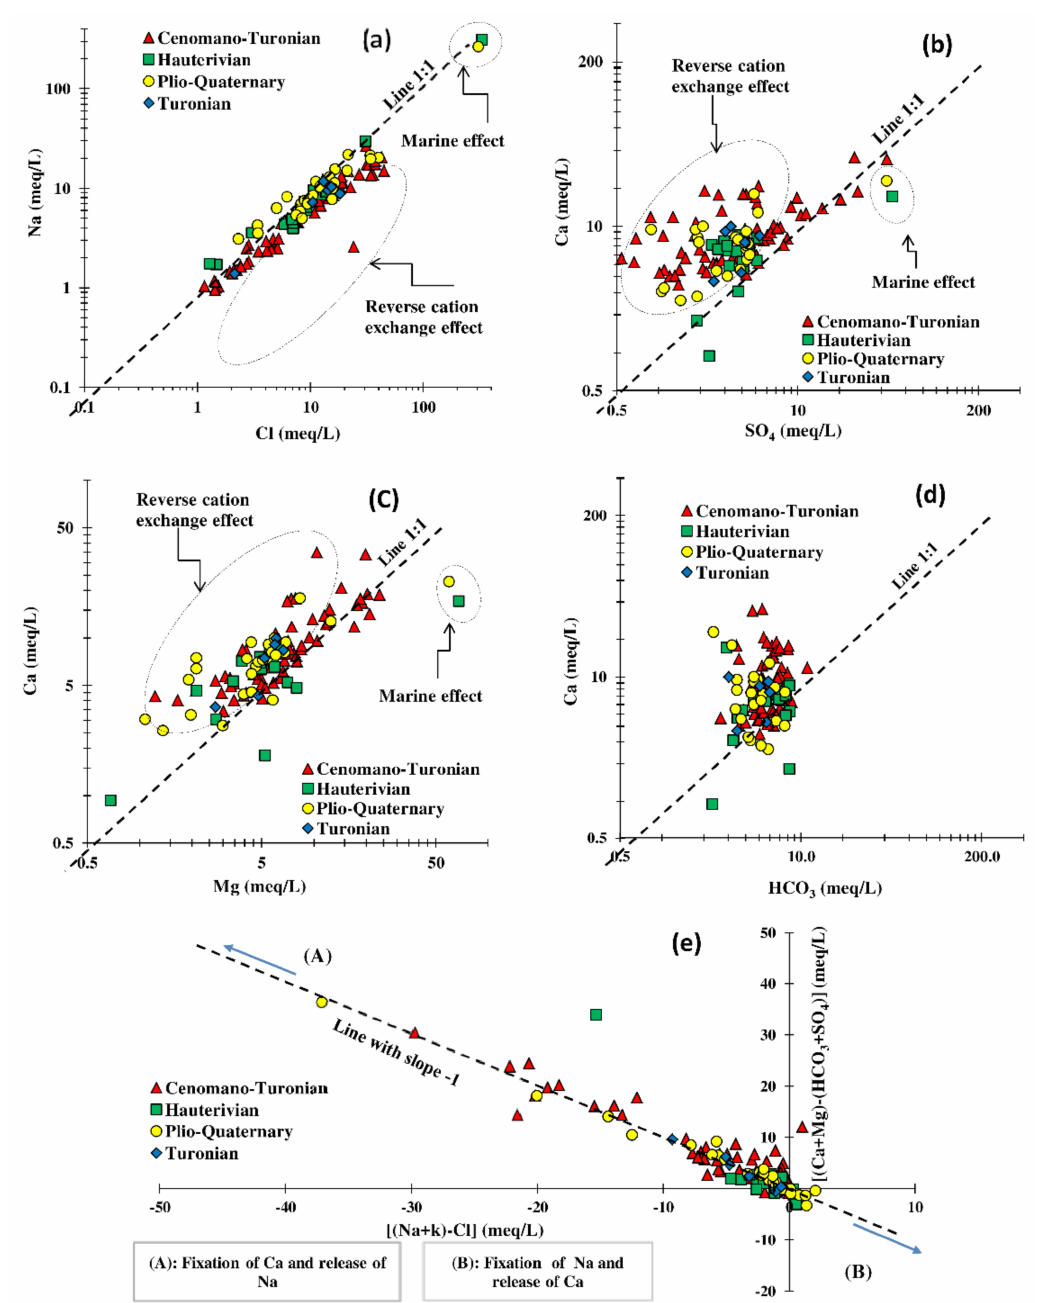
Figure 14. Correlation diagrams: ( a ) Na + vs. Cl − , ( b ) Ca 2+ vs. SO 42 − , ( c ) Ca 2+ vs. Mg 2+ , ( d ) Ca 2+ vs. HCO 3 − , and ( e ) Ca